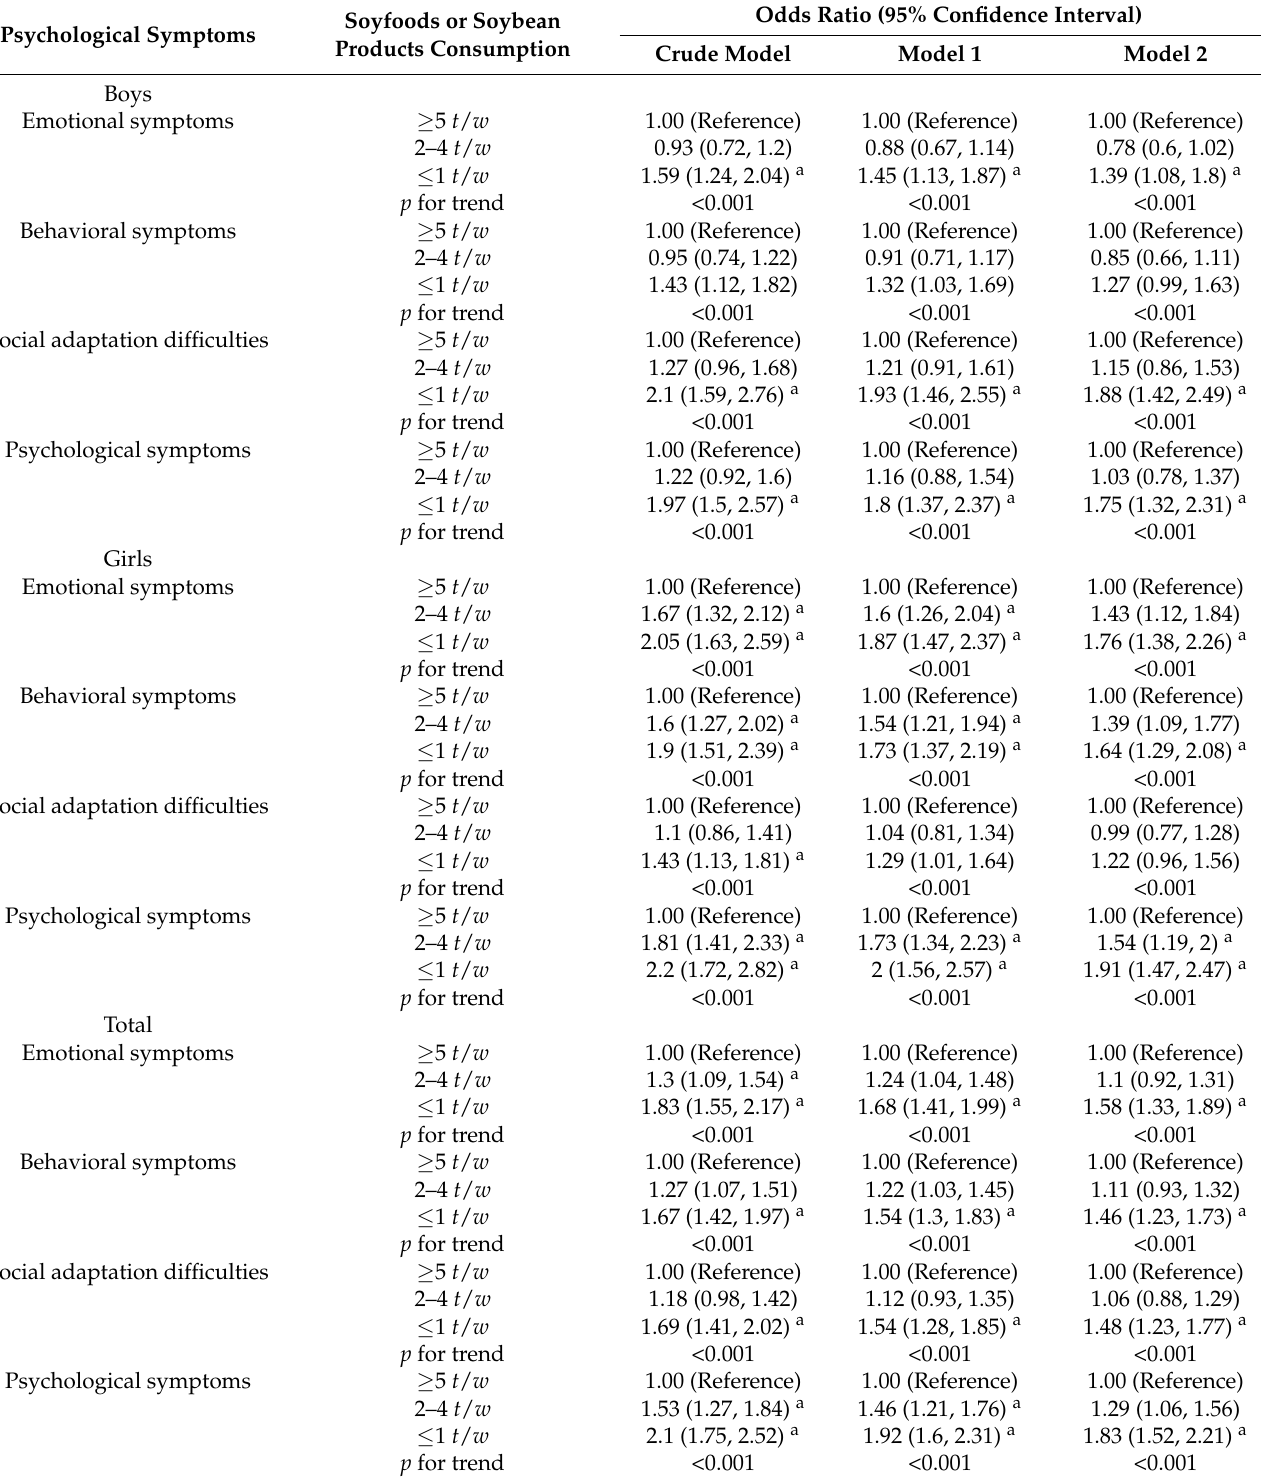
Table 3. Logistic regression analysis of university students’ soyfoods or soybean products consump- tion and psychological symptoms in China ( n =